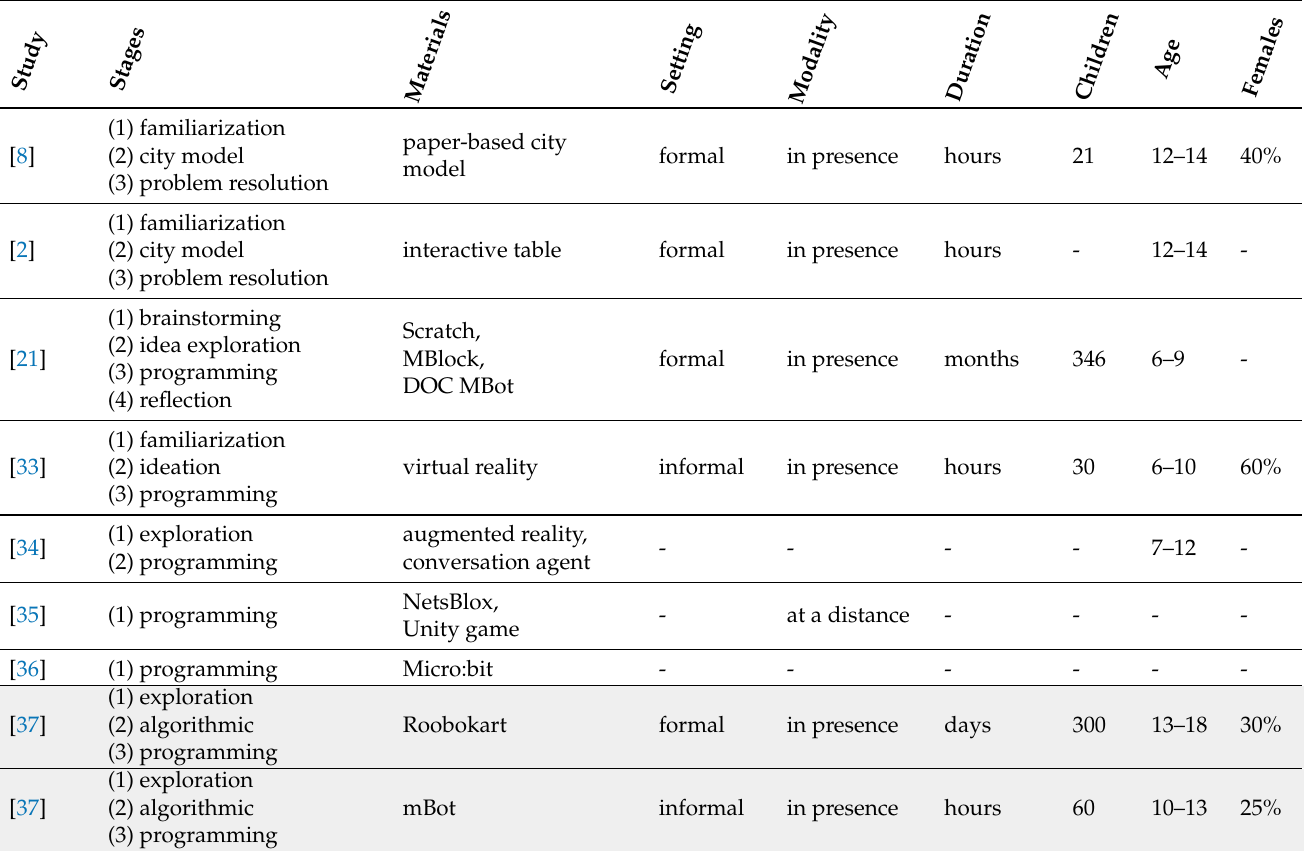
Table 1. Summary of smart city design workshops with children.